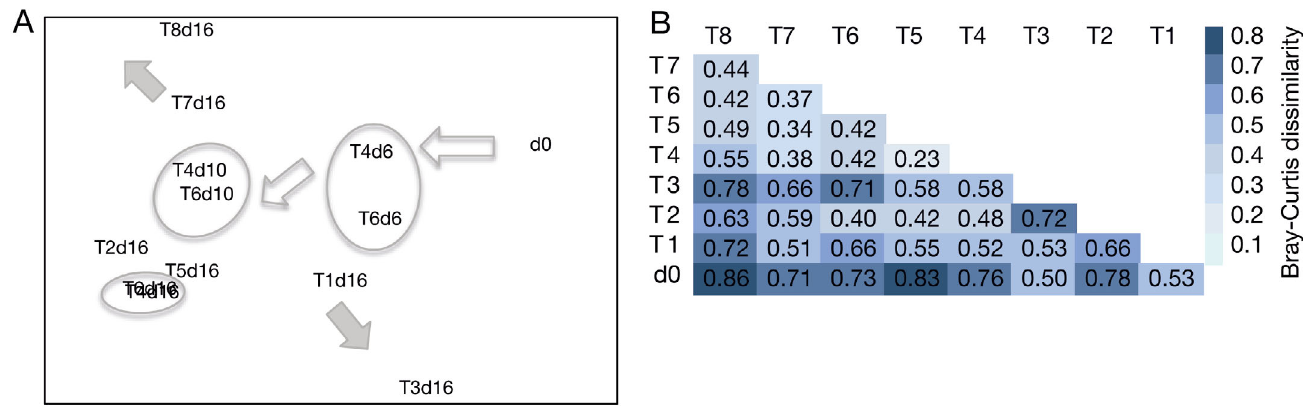
Fig. 3. (A) Non-metric multidimensional scaling (NMDS) ordination where the distances between samples are based on the ranks of the Bray-Curtis dissimilarities between 16S DGGE fingerprints from the 8 treatments (T1−8, Table 1) and Day 0 (d0) of the microcosm experiment, with day (d) number denoted. The figure shows axis 1 and 2 of a 3-dimensional ordination (stress = 0.054, R 2 = 0.98). The white arrows indicate the direction of bacterial community succession of T4 and T6 (encircled), and the grey arrows indicate the divergence of the community structure in the samples from Day 16. (B) Bray-Curtis dissimilarity matrix for the 16S DGGE fingerprints from all treatments on Day 16 and the Day 0